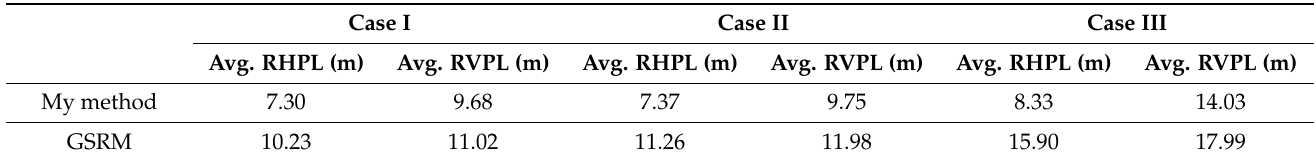
Figure 7. The RPL results of my method and GSRM in three different cases. Specifically, the Relative Horizontal Protection Level (RHPL) and the Relative Vertical Protection Level (RVPL) are estimated and compared separately to test the performance of the proposed method, ( a ) RPL results in Case I; ( b ) RPL results in Case II; ( c ) RPL results in Case III. Table 3. The average RPLs in different cases.